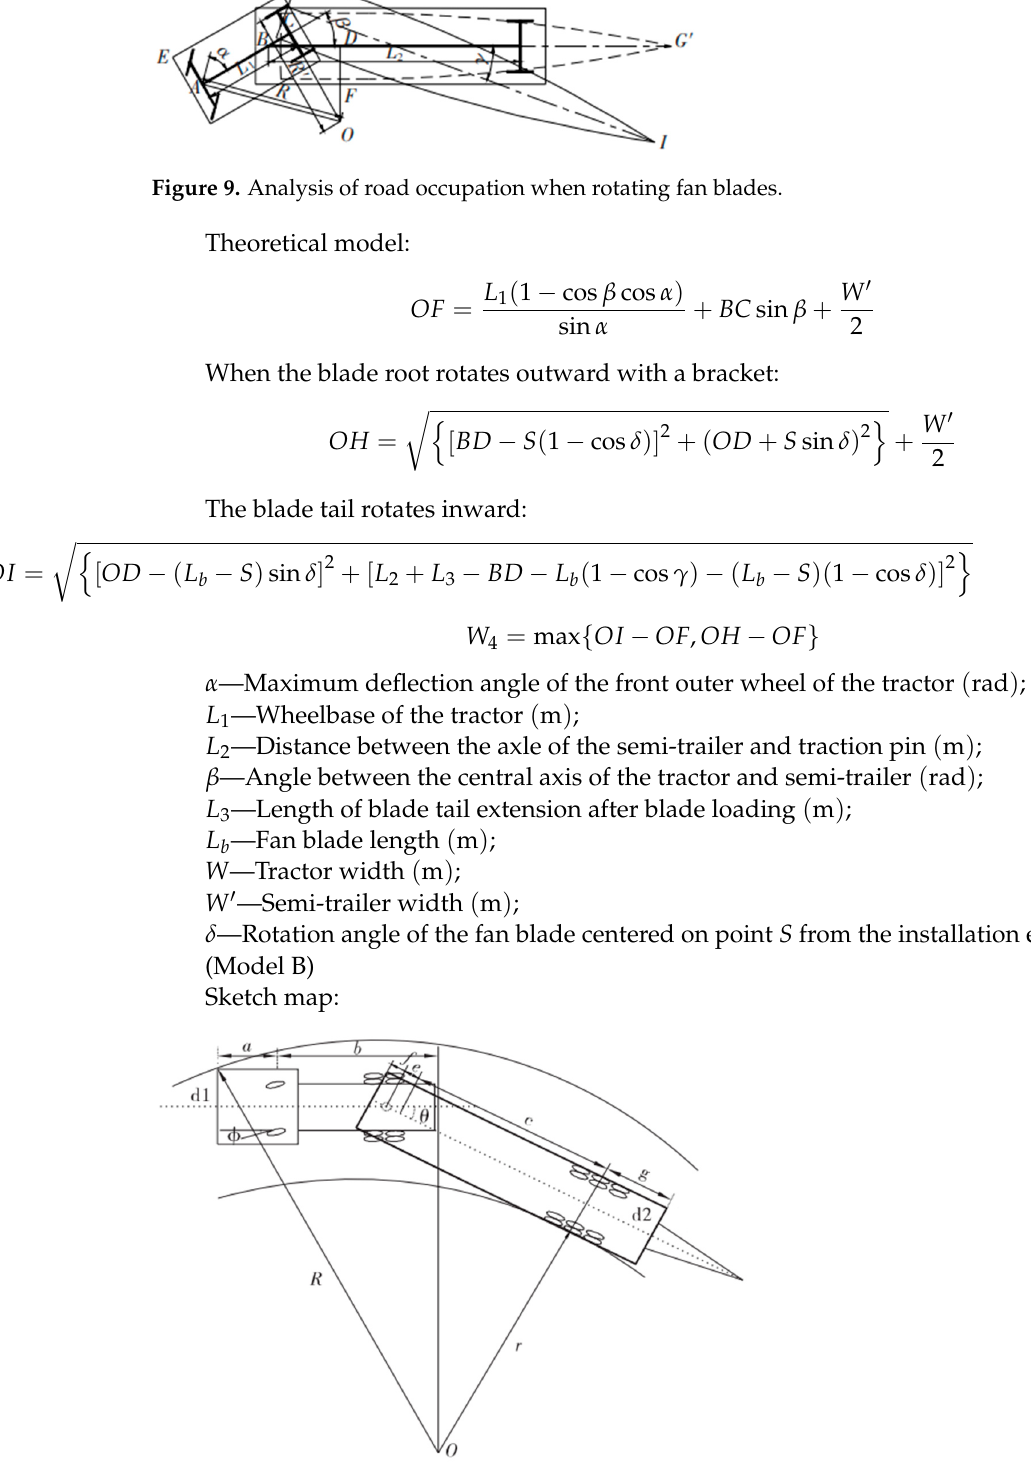
Figure 10. The sketch of horizontal curve radius calculation considering whipping suspension steady-state turn.